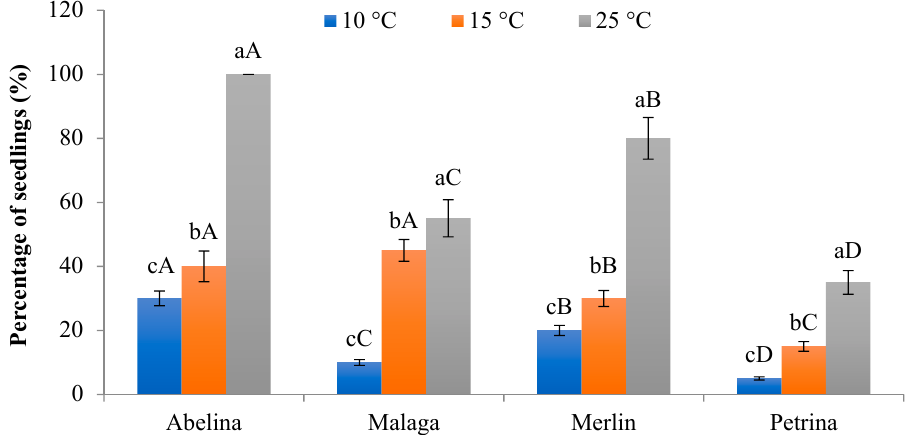
Figure 4. Percentage of seedlings grown from the entire pool of seeds germinated for 48 h at different temperatures. The percentage of seedlings was calculated one week after the seed transfer into pots filled with soil and cultivated at 25 ◦ C. Values represent means ( n = 25) ± SE. The values for each cultivar followed by the same lowercase letter do not differ significantly, while means for the same temperature marked with the same uppercase do not differ significantly according to Duncan’s multiple range test ( p < 0.05).